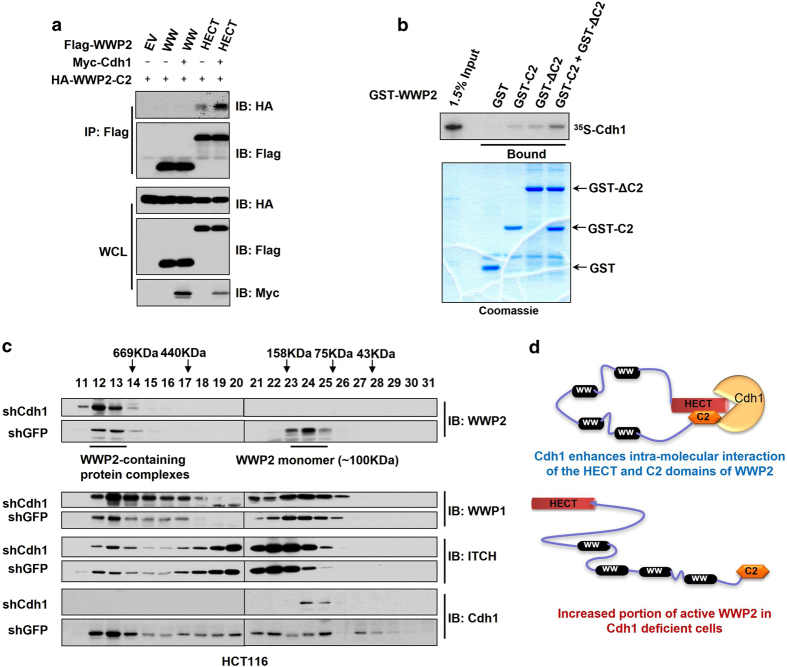
Cdh1 promotes the intramolecular interaction of WWP2. (a) Immunoblot (IB) analysis of whole-cell lysates (WCL) and immunoprecipitates (IP) derived from 293 T cells transfected with the indicated Cdh1 and WWP2 constructs. Thirty-six hours post transfection, the cells were pretreated with 10 μM MG132 before collecting. (b) Autoradiography of 35S-labeled Cdh1 bound to the indicated GST-fusion proteins. (c) Gel filtration experiments to illustrate that depletion of endogenous Cdh1 promotes WWP2 oligomer formation in cells. IB analysis of the indicated fractionations derived from the gel filtration experiment with shGFP or shCdh1 infected HCT116 cells. Before running cell lysates, the molecular weight resolution of the column was first estimated by running native molecular weight markers (thyroglobulin ~669 KDa, ferritin ~440 KDa, aldolase ~158 KDa, conalbumin ~75 KDa and ovalbumin ~44 KDa) and determining their retention times on Coomassie-stained SDS–PAGE protein gels. (d) A proposed model of how the WWP2 E3 ligase activity is suppressed by Cdh1 via enhancing WWP2 intramolecular interaction-mediated auto-inhibition. PAGE, polyacrylamide gel electrophoresis.